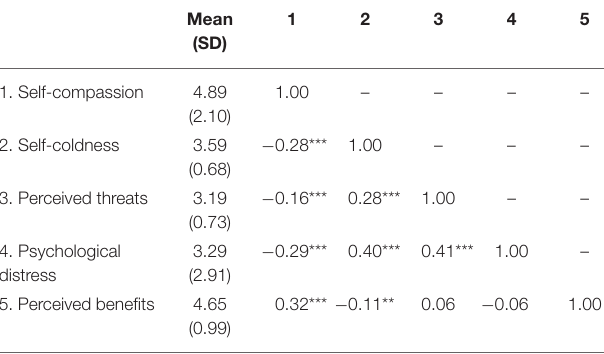
TABLE 2 | Intercorrelations among the key variables ( N =